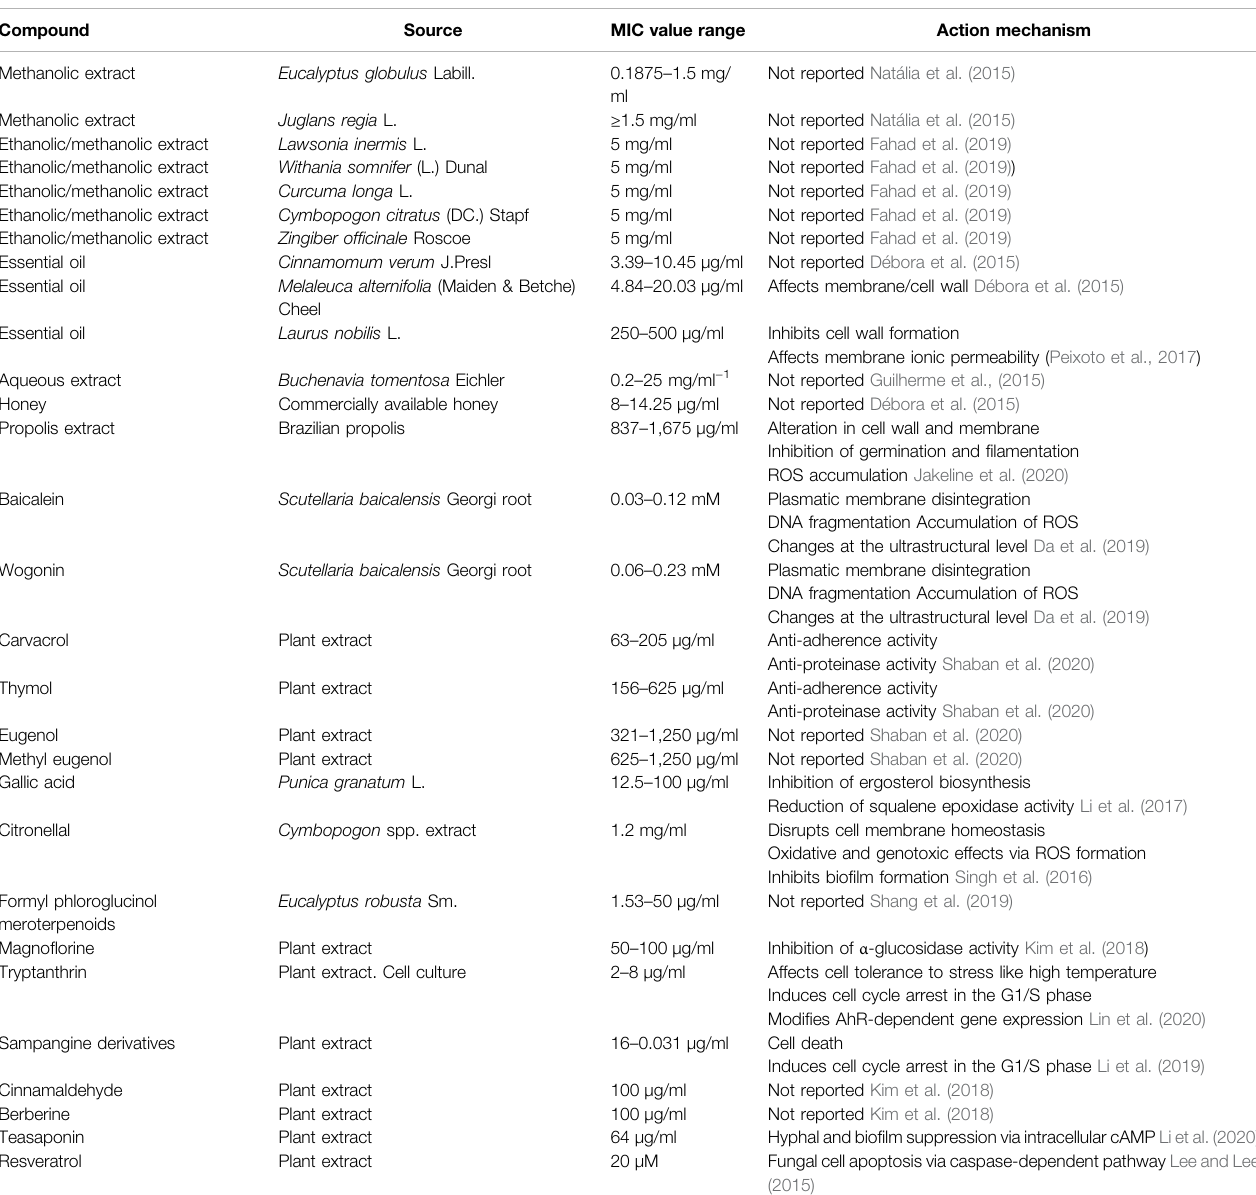
TABLE 5 | Mechanism of action of antifungal compounds of natural